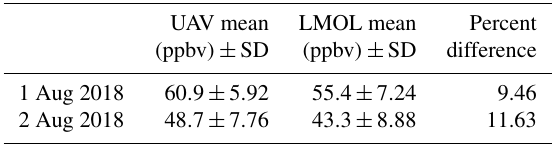
Table 2. UAV and LMOL comparison for 1 and 2 August for sam- plings taken above LMOL above 120m. The data sample standard deviations are also shown along with the mean